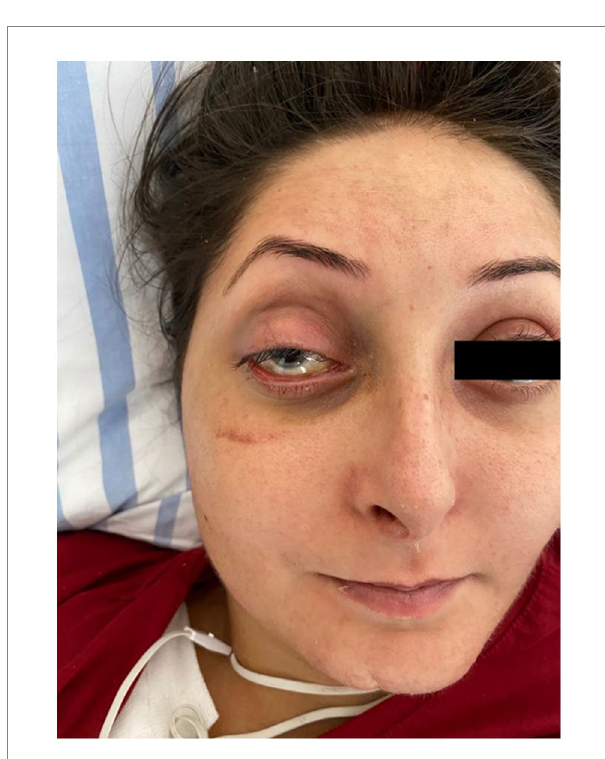
FIGURE 2 Patient’s appearance: narrow nose, translucent skin, thin vermilion